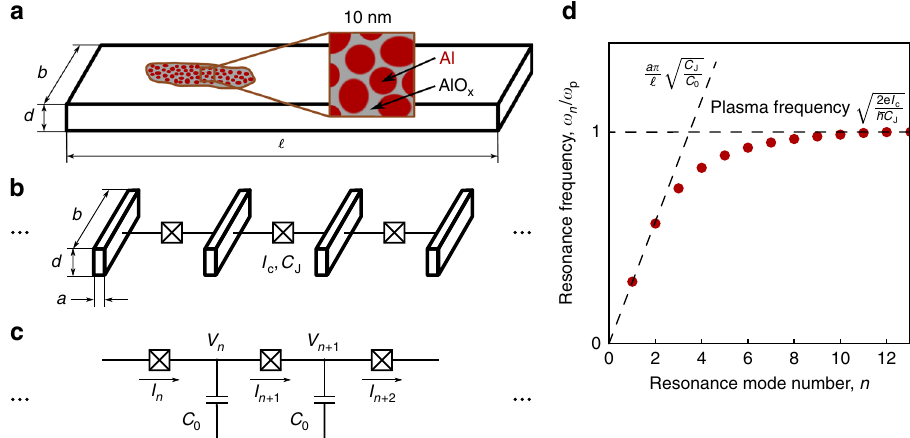
Fig. 1 Schematic representation of a grAl stripline resonator with open-boundary conditions. a The length of the stripline, ‘ , is in the range of mm, its width, b , is in the range of a few μ m, and the thickness, d , is between 20 and 30 nm. Al grains (sketched in bordeaux color in the inset) have a diameter a = 3 ± 1 nm 4 . They are separated by aluminum oxide barriers (shown in gray), forming a 3D network of superconducting islands connected by Josephson contacts. b For the lowest-frequency standing-current modes along the stripline, the resonator can be modeled as a 1D array of effective Josephson junctions with critical current I c and junction capacitance C J , corresponding to the summed critical currents and capacitances of the grains in a stripline section of length a . c The resulting circuit diagram consists of identical cells, each containing an effective JJ and the self capacitance C 0 of the superconducting island. d Typical ffiffiffiffiffiffiffiffiffiffiffiffiffiffiffiffiffi ¼ = (cid:1) hC dispersion relation of a 1D JJ array, following Eq. (3). The spectrum saturates at the effective plasma frequency ω . The slope in the linear part 2 eI ffiffiffiffiffiffiffiffiffiffiffiffi p c J C = C of the dispersion relation is de fi ned by the ratio a π ‘ 0 J